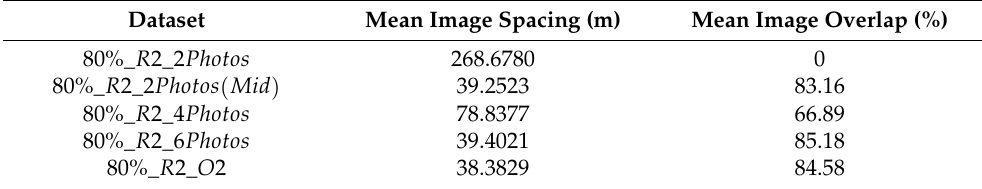
Table 10. The mean image spacing and overlap results under different oblique imaging numbers and position